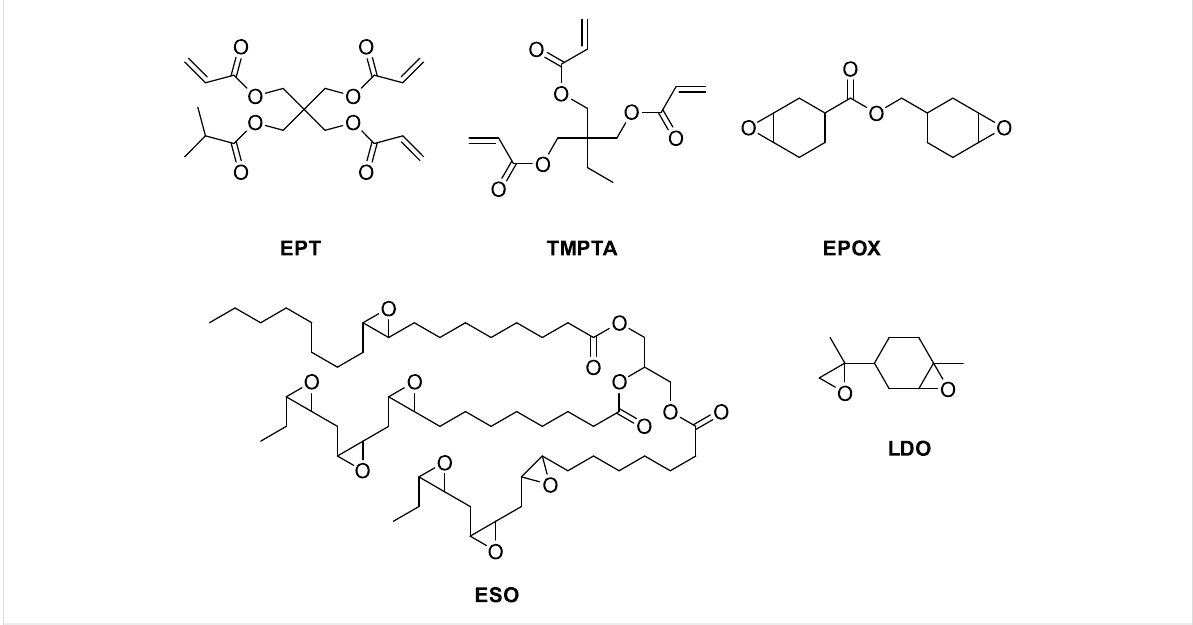
Figure 4: Typical monomers that can be polymerized through a photoredox catalysis approach.